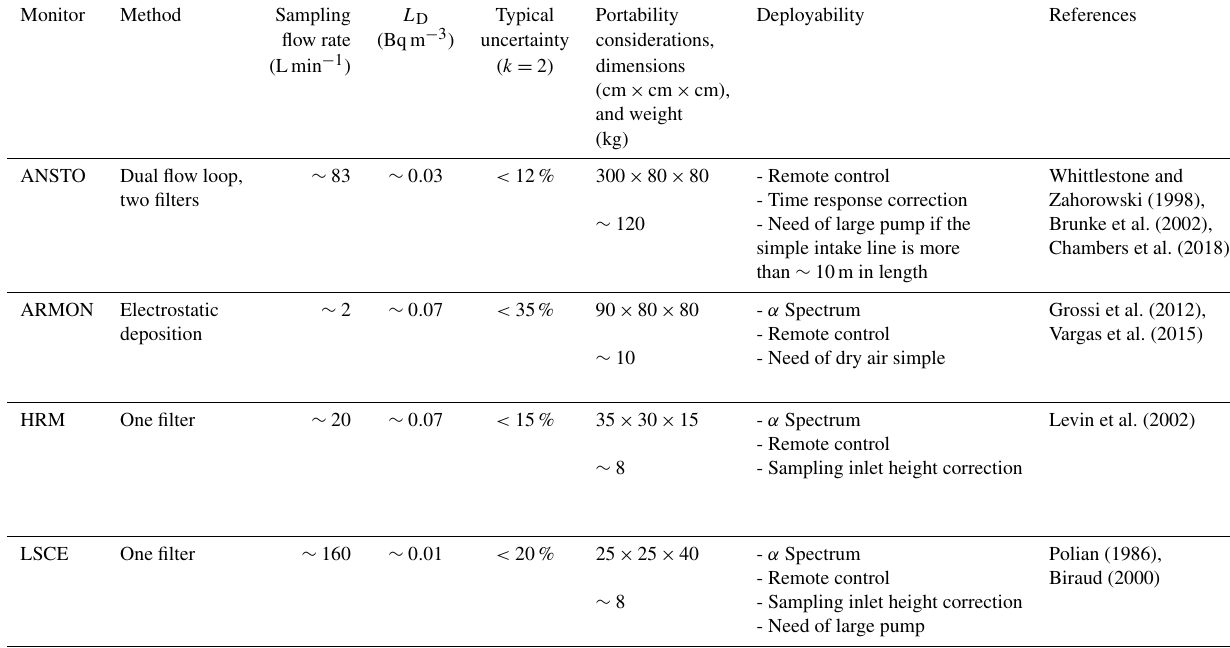
Table 1. Summary of principal characteristics of the 222 Rn and 222 Rn progeny monitors compared in the present